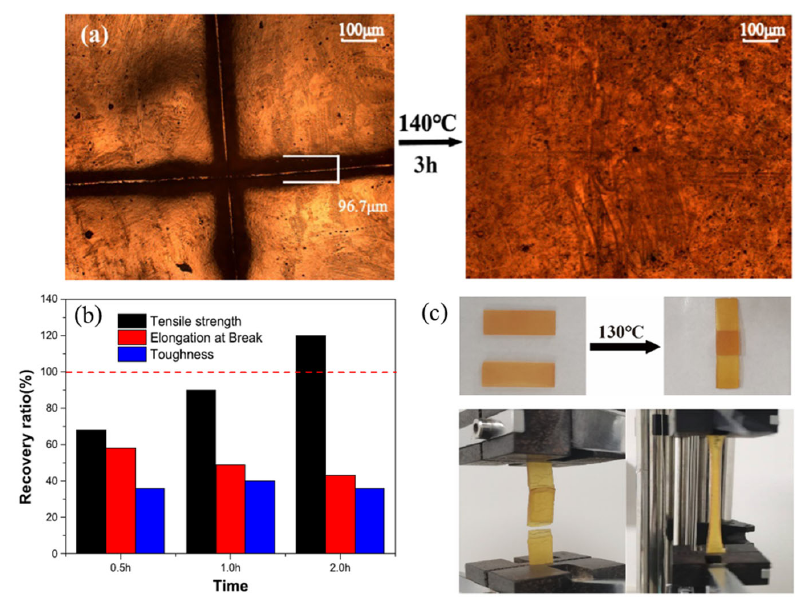
Figure 9. Self ‐ healing of shape memory elastomer from HTPB–PU; ( a ) optical images of self ‐ healing Figure 9. Self-healing of shape memory elastomer from HTPB–PU; ( a ) optical images of self-healing behaviour of HTPB–PUV, ( b ) recovery ratio of mechanical properties of HTPB–PUV fusing at 130 ◦ C for different treating times of 0.5, 1.0, and 2.0 h, and ( c ) optical microscope images of before/after fusing and lap shear testing of HTPB–PUV [86]. Adapted with permission from [86]. Copyright 2022 American Chemical